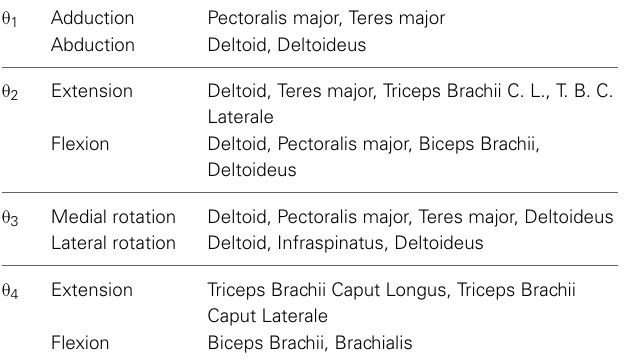
Table 1 | Muscles measured for EMG signals.